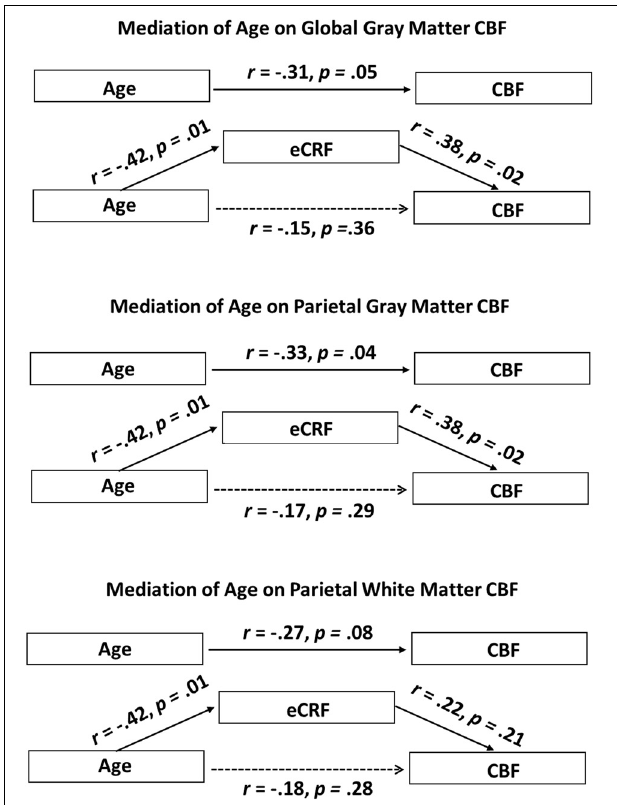
FIGURE 5 | Schematic representations of mediation analyses. Top panel: Schematic representation of the results of the mediation analysis performedwiththeglobalgraymatterCBFasthedependentvariable. Middle panel : Schematic representation of the results of the mediation analysis performed with the parietal gray matter CBF as the dependent variable. Bottom panel : Schematic representation of the results of the mediation analysis performed with the parietal white matter CBF as the dependent variable. eCRF significantly mediates the effect of age on CBF in the global gray matter and parietal gray matter, but not in the parietal white matter.